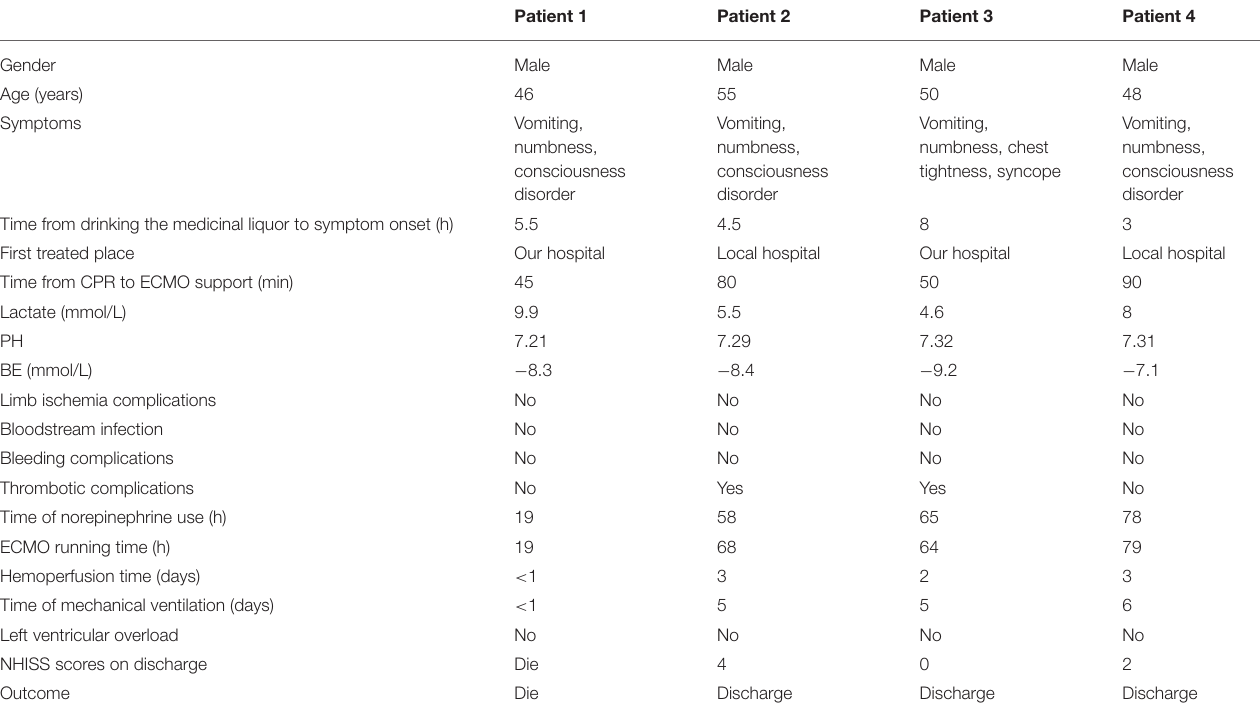
TABLE 1 | The clinical characteristics of the four